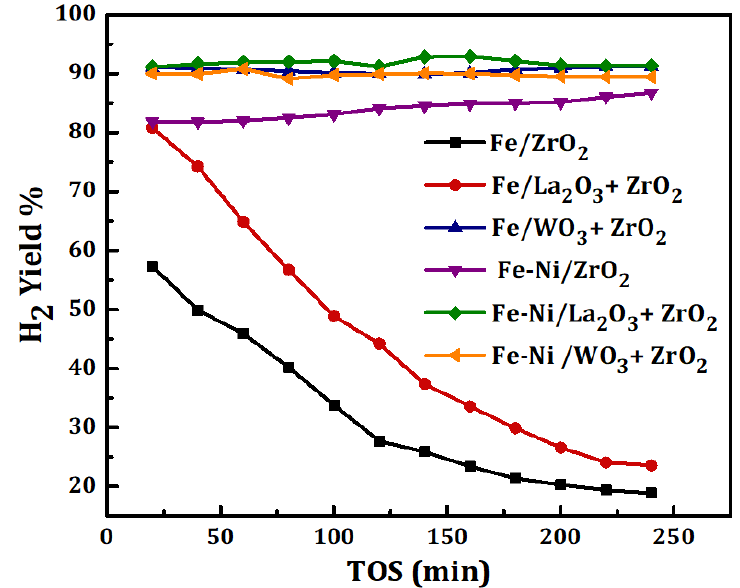
Figure 4. H 2 yield for Fe, Fe-Ni/x-ZrO 2 (x = 0, La 2 O 3 , WO 3 ) catalysts studied at 1 atm, 800 °C, and 4000 mL(hg cat ) −1 .